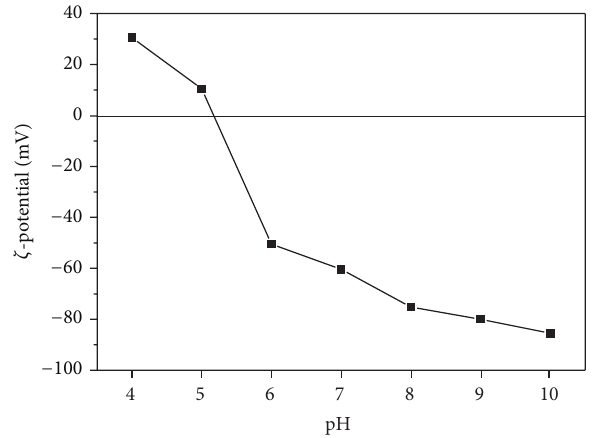
Figure 1: 𝜁 -potentials of Fe@SiO 2 as a function of solution